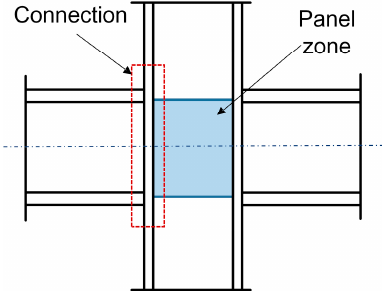
Figure 5. Joint (connection + web panel).